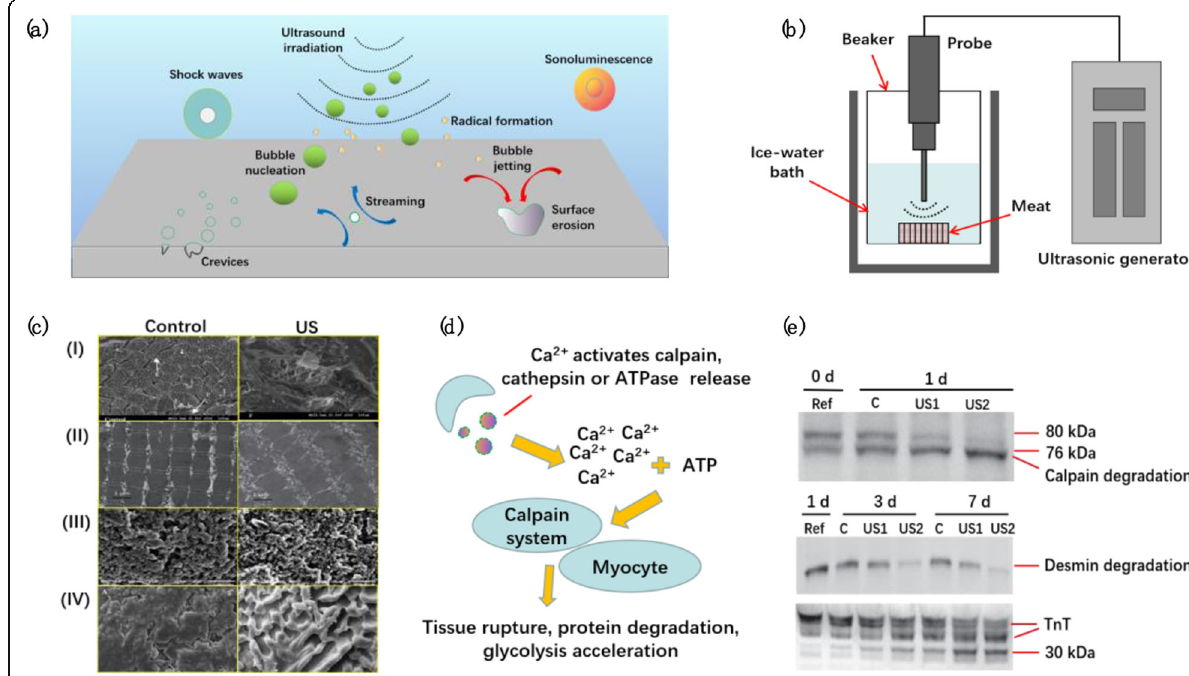
Fig. 7 Schematic representation of ultrasound on tenderising meat. a Ultrasonic effects on meat (Alarcon-Rojo et al. 2019, with modification). b Current classic ultrasound device. c Optimized microstructure of tissue (I), myofibrils (II), protein (III), and gel (IV). d Protease activation. e Protein/ protease degradation (Wang et al.